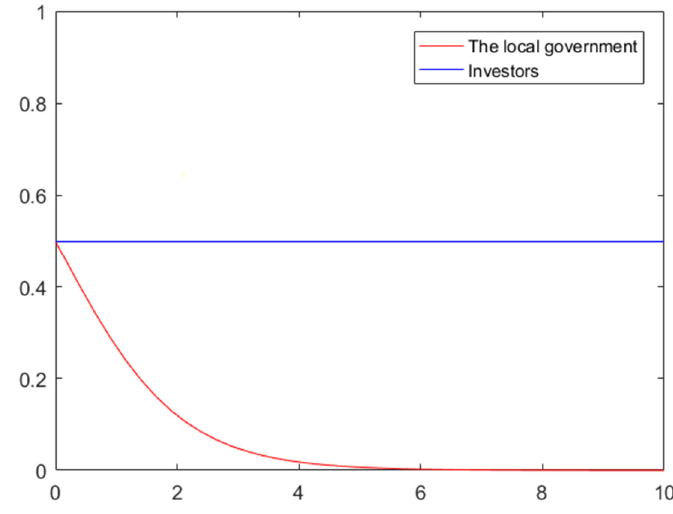
Figure 2. Simulation results in the bubble-free stage.